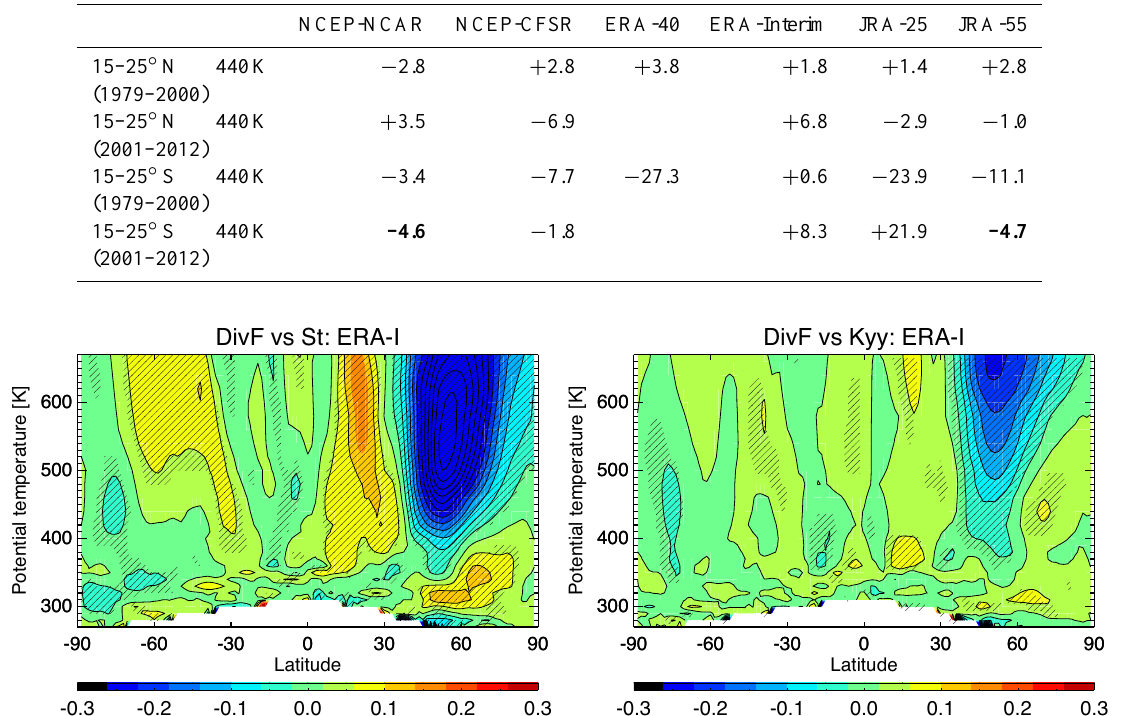
Figure 10. Latitude and potential temperature cross section of the correlation (left) between the 6-hourly mass stream function at 50 ◦ N, 440K and the 6-hourly E–P flux divergence at each grid point, and (right) between Kyy ( l = 1 day) at 50 ◦ N, 560K, and the 6-hourly E–P flux divergence at each grid point in DJF in 2000–2012. Correlation coefficients at the 95% confidence level (following t test) are indicated by